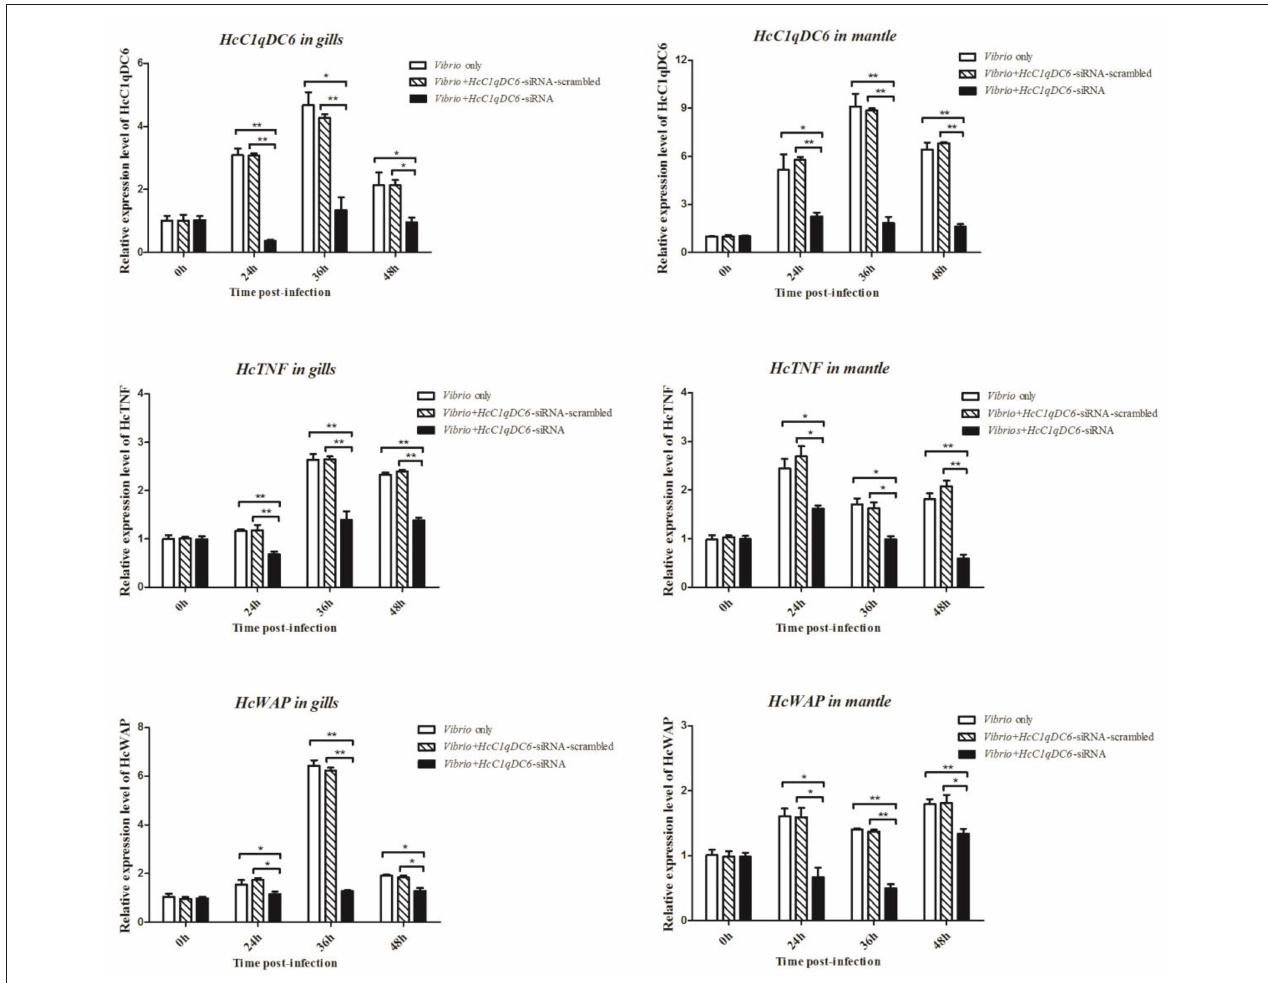
FIGURE 6 | HcTNF and HcWAP expression analyses of the HcC1qDC6 knocking down H. cumingii challenged by V. parahaemolyticus . Asterisks indicate significant differences (* P < 0.05, ** P < 0.01) when compared with the control. Error bars represent ± SD of the three independent PCR amplifications and